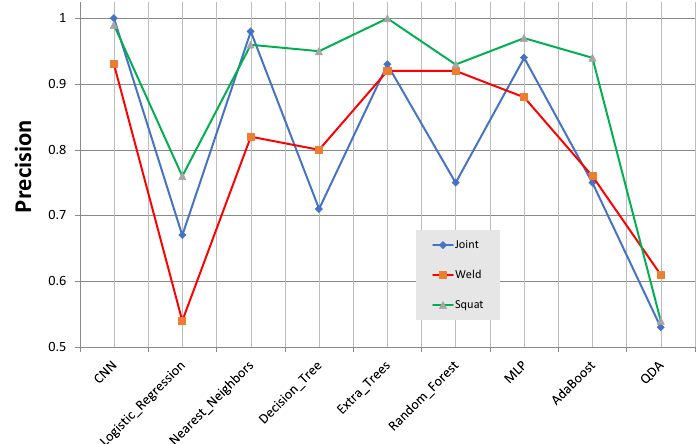
Figure 16. Classifiers’ precision comparison.